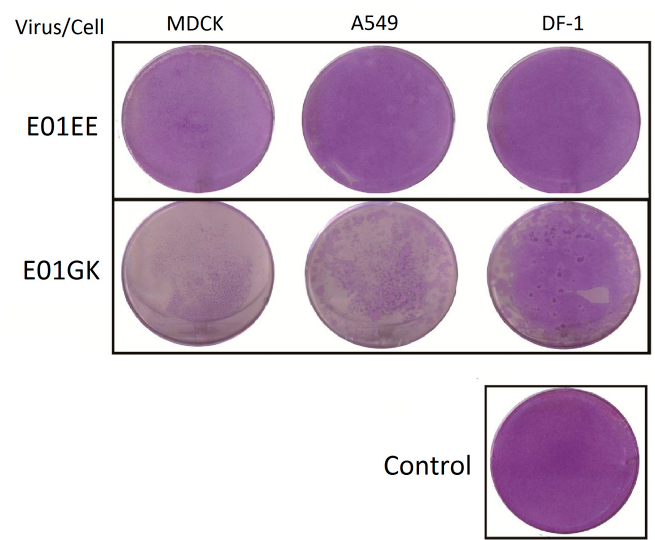
Figure 2. The comparison of plaque formation. MDCK, A549 and DF-1 cells were infected with 0.01 MOI of viruses for 1 h and the culture supernatants at 24 h.p.i. were collected for plaque assay on MDCK cells.